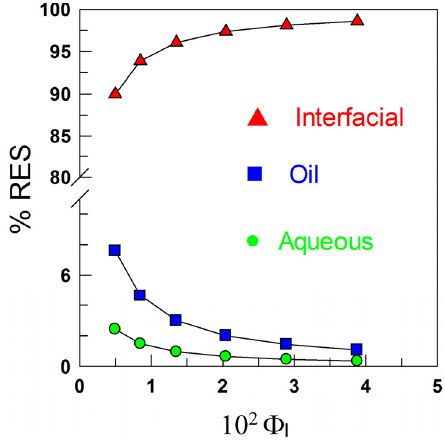
Figure 4. Distribution of resveratrol in a 4:6 (O/W) corn oil/Tween 20/acidic water emulsion.